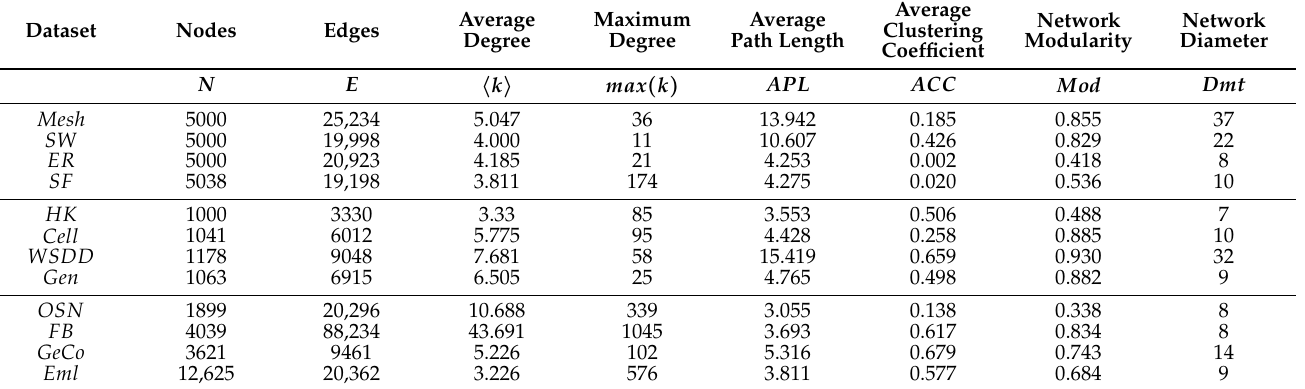
Table 1. Network measures for the validation datasets divided into fundamental, complex synthetic and real-world